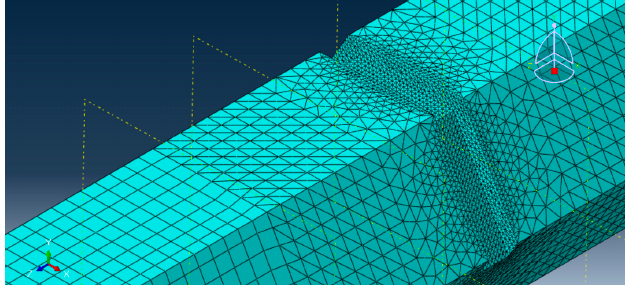
Figure 9. An example of meshing results for a hexagonal drill pipe with an asymmetric damage.